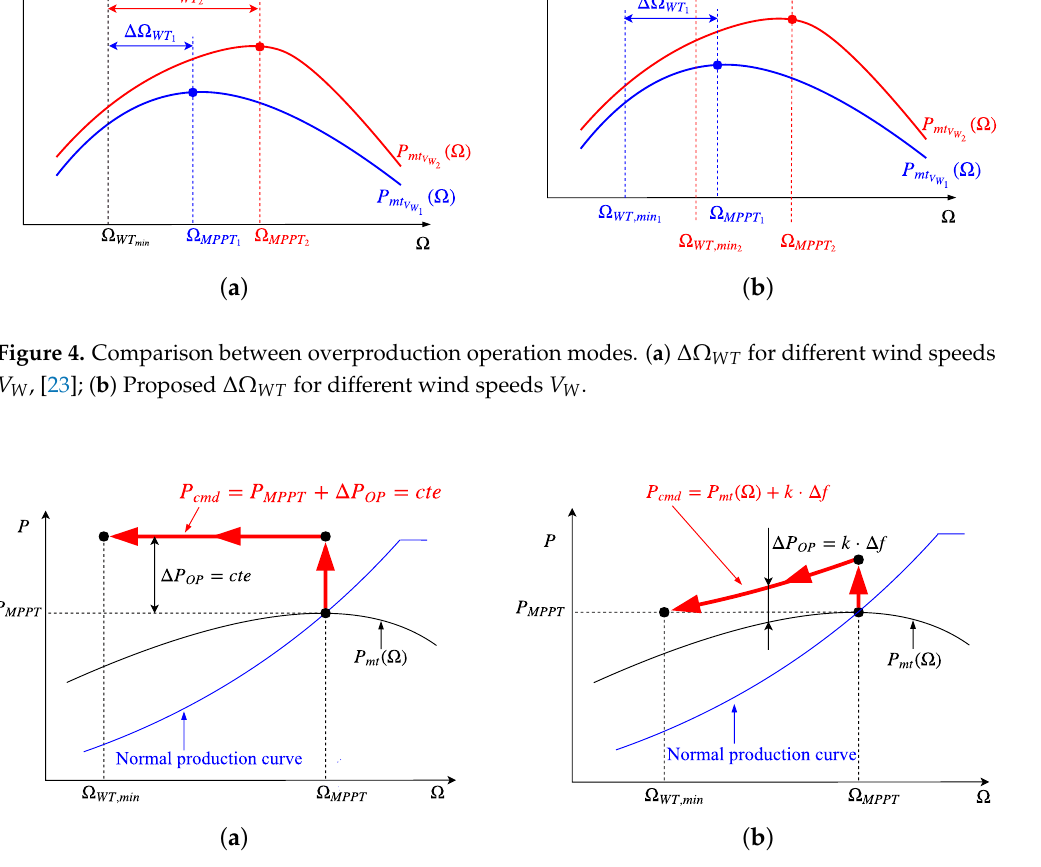
Figure 5. Comparison between overproduction operation modes; ( a ) Overproduction operation mode in [23]; ( b ) Overproduction operation mode